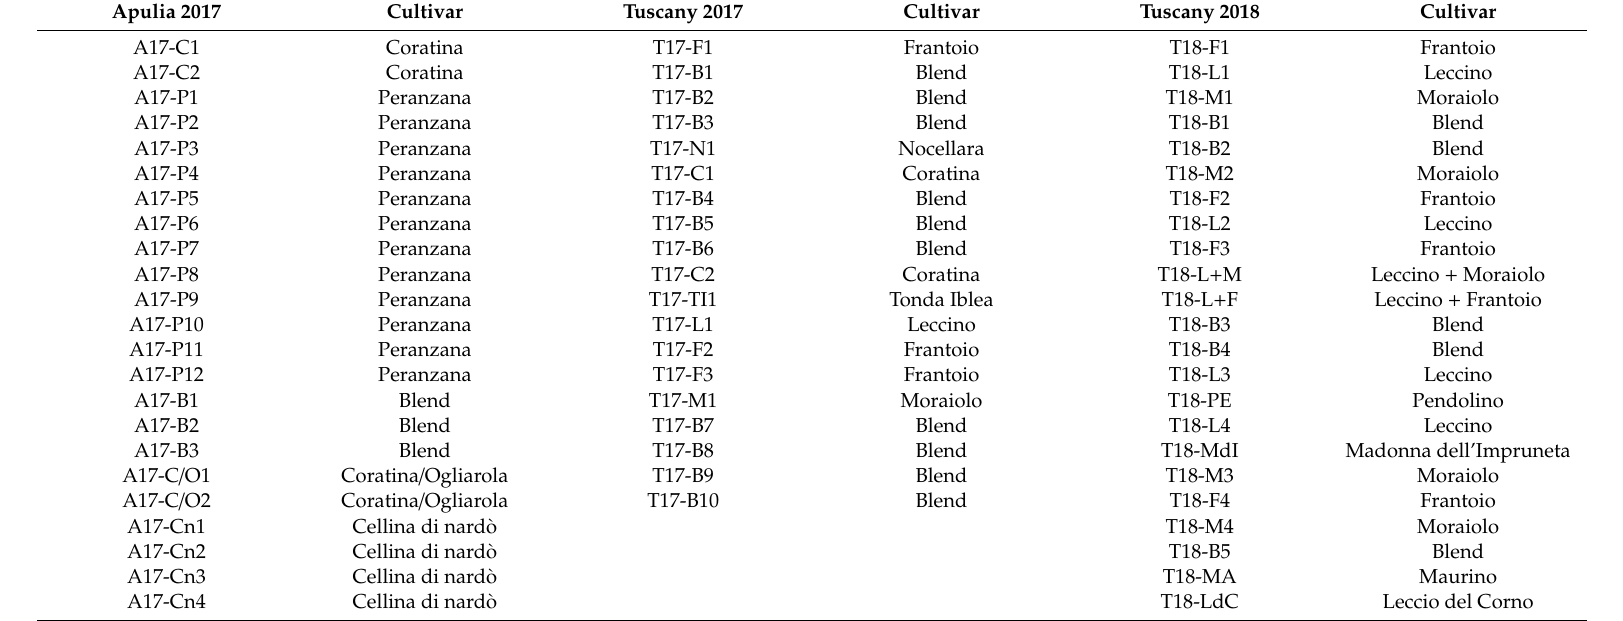
Table 3. Analyzed oils produced in Tuscan (T) and Apulian (A) olive mills. F, Frantoio; No, Nocellara; C, Coratina; TI, Tonda Iblea; M, Moraiolo; L, Leccino; P, Peranzana; Cn, Cellina di Nard ò ; O, Ogliarola; PE, Pendolino; MdI, Madonna dell’Impruneta; MA, Maurino; LdC, Leccio del Corno; B,